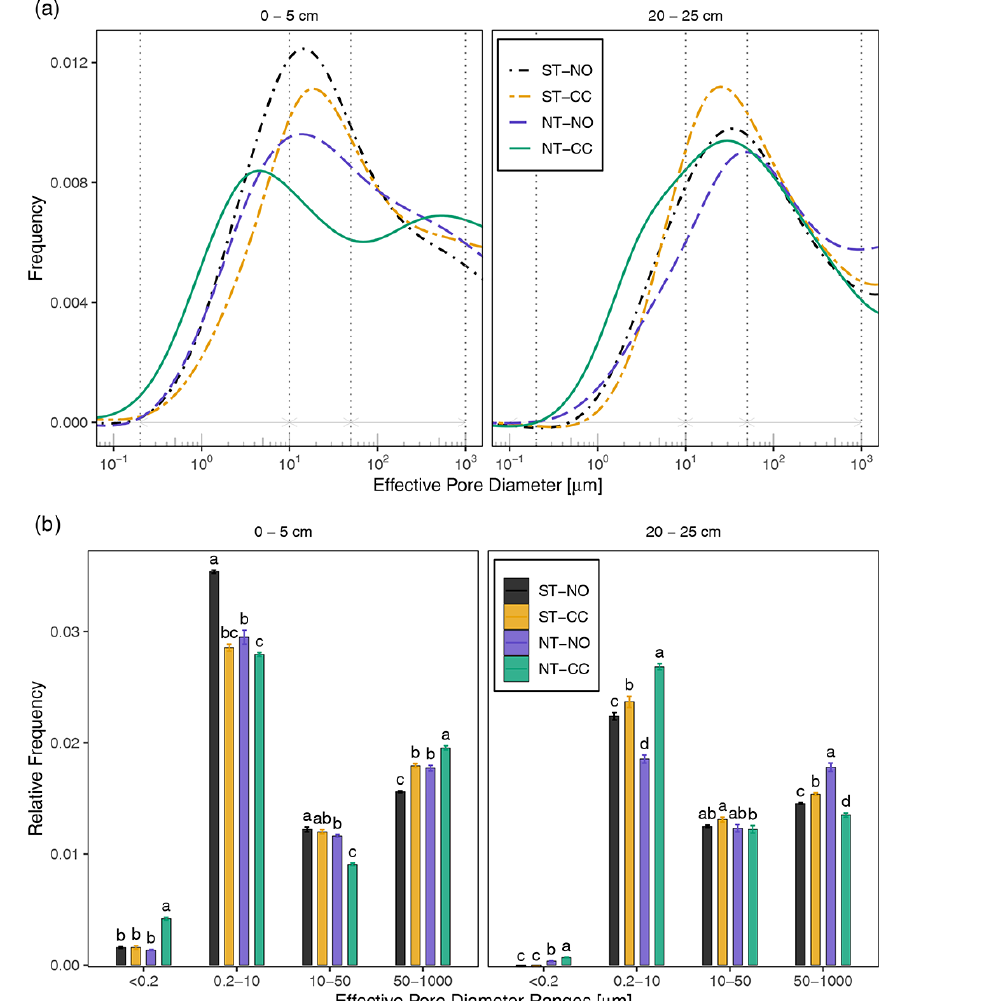
Figure 5. (a) Pore size distribution for the top (0–5cm) and subsurface (20–25cm) soil layers. Dotted vertical lines and horizontal arrows in- dicate the characteristic pore diameter ranges of < 0 . 2, 0.2–10, 10–50, and 50–1000µm. (b) The relative abundance of the four characteristic pore diameter ranges. Bars indicate standard errors. Different letters within the same pore size range indicate differences at p < 0 .